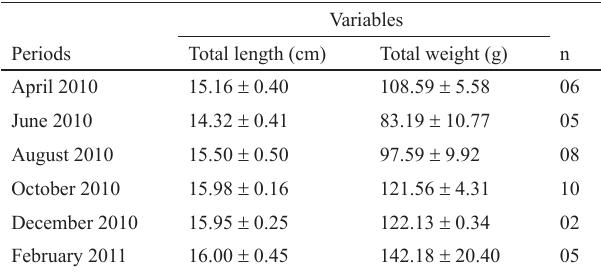
Table 1. Biometrical parameters of female Metynnis macula- tus during different time periods (mean ±